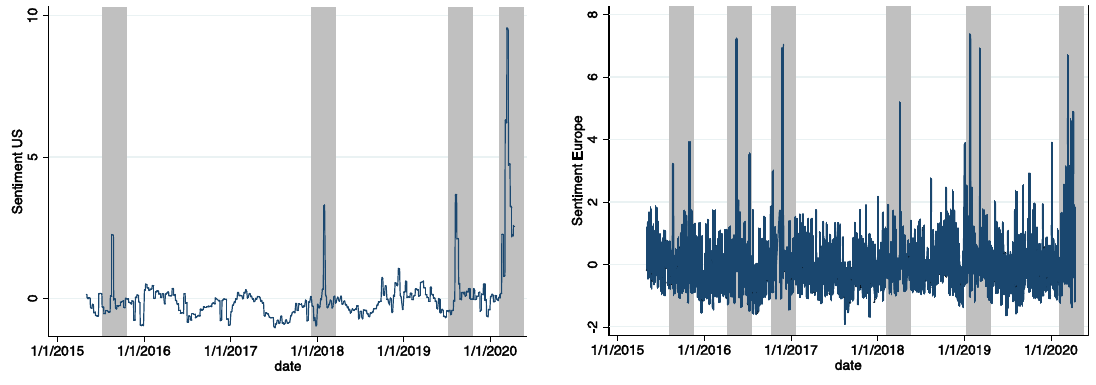
Figure 1. Sentiment for Europe and for the US